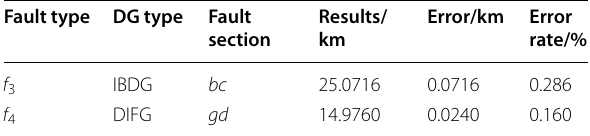
Table 3 Simulation results of fault location with